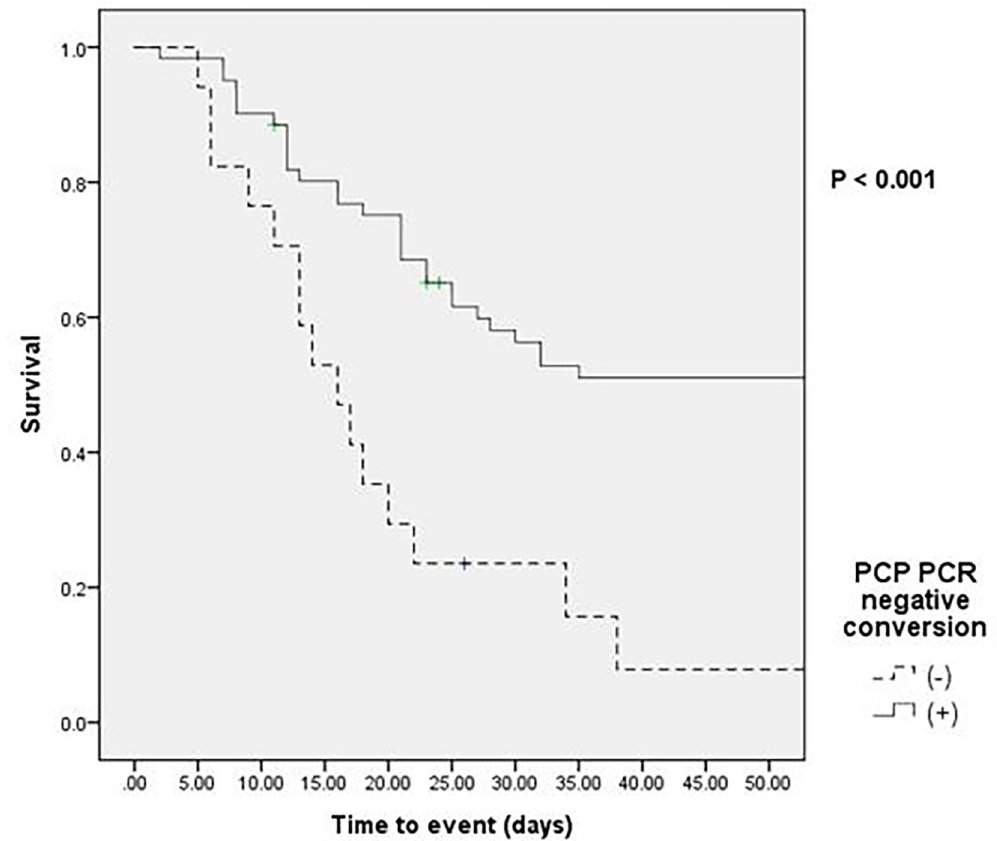
Fig 3. Kaplan-Meier survival curves for non-HIV PCP patients with respiratory failure. Solid line, no PCP PCR conversion. Broken line, PCP PCR negative conversion. PCP, Pneumocystis jirovecii pneumonia; PCR, polymerase chain